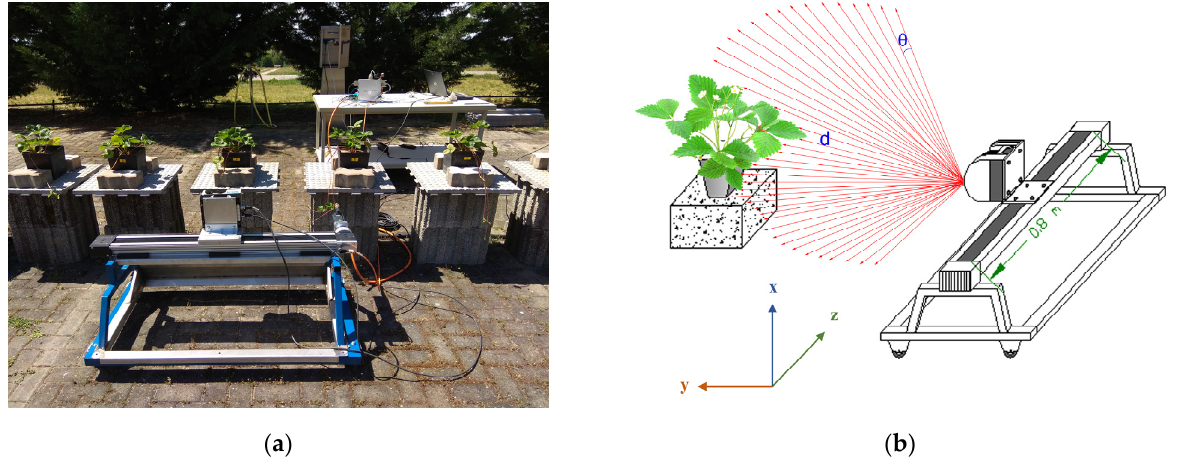
Figure 1. ( a ) Photograph of the LiDAR laser scanning system (LMS511 pro, Sick AG, Düsseldorf, Germany) during strawberry plant measurement and ( b ) a schematic view of the LiDAR system mounted on a linear conveyor measuring strawberry 3D point cloud. θ is the angular step and d is the measured distance by the LiDAR laser scanner.